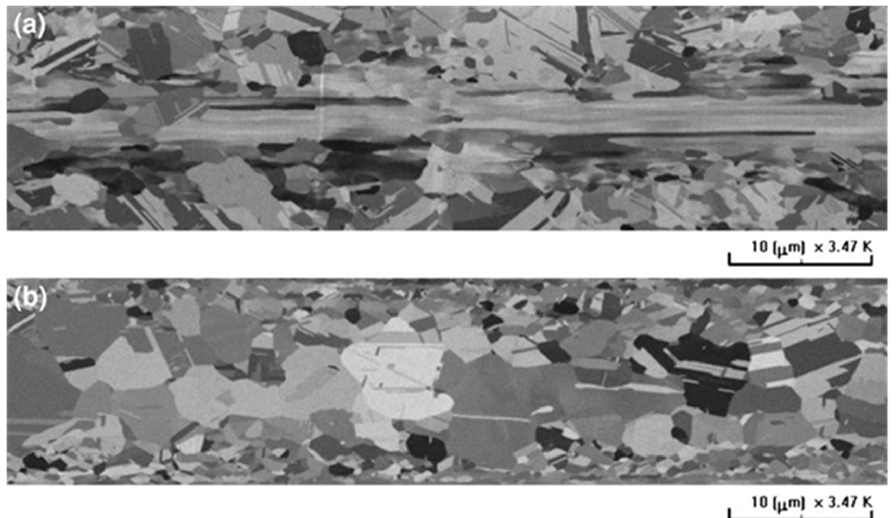
Figure 11. Variation curve of tensile strength and elongation of Ag-4Pd wire during cold defor- mation [145]. Reproduced with permission from Ref. [145]; published by Journal of Mechanical En- gineering, 2016.